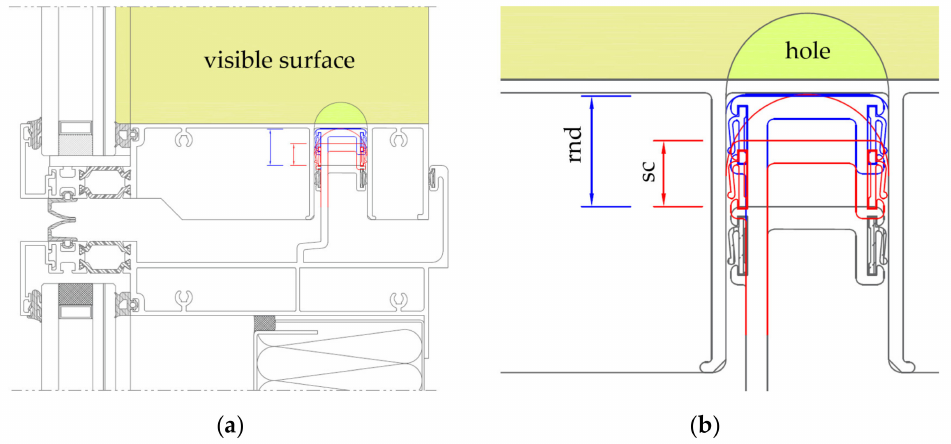
Figure 7. ( a ) Stack joint; ( b ) enlarged detail showing the vertical movement capacity.